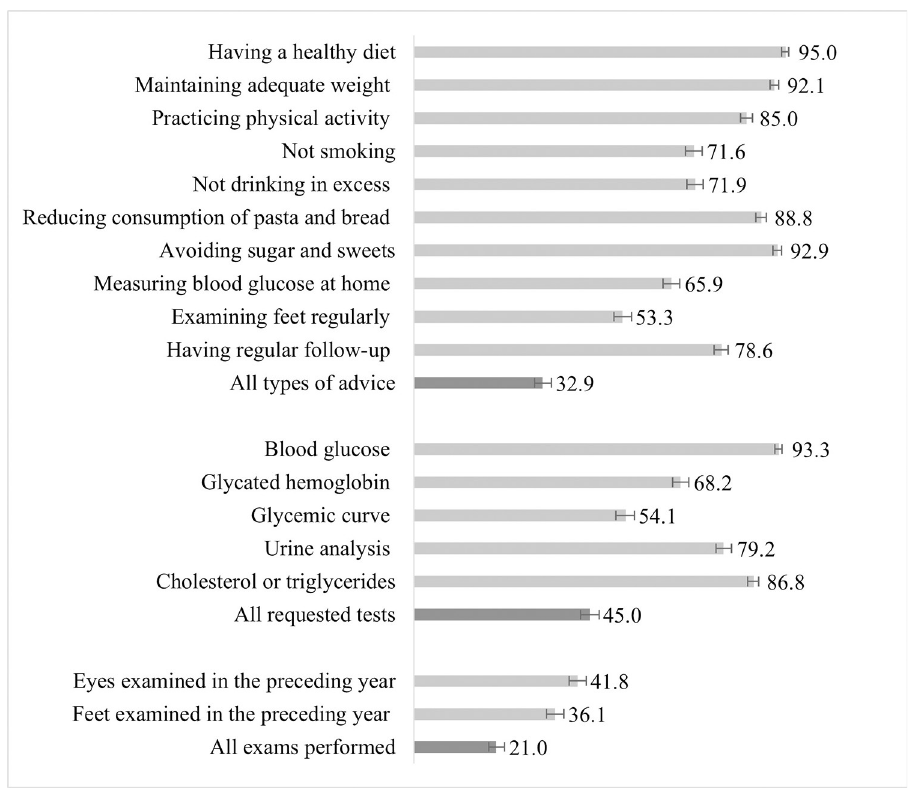
Fig 1. Prevalence (%) of the care services offered to the people with diabetes mellitus, Brazil, 2019, (N = 6317).